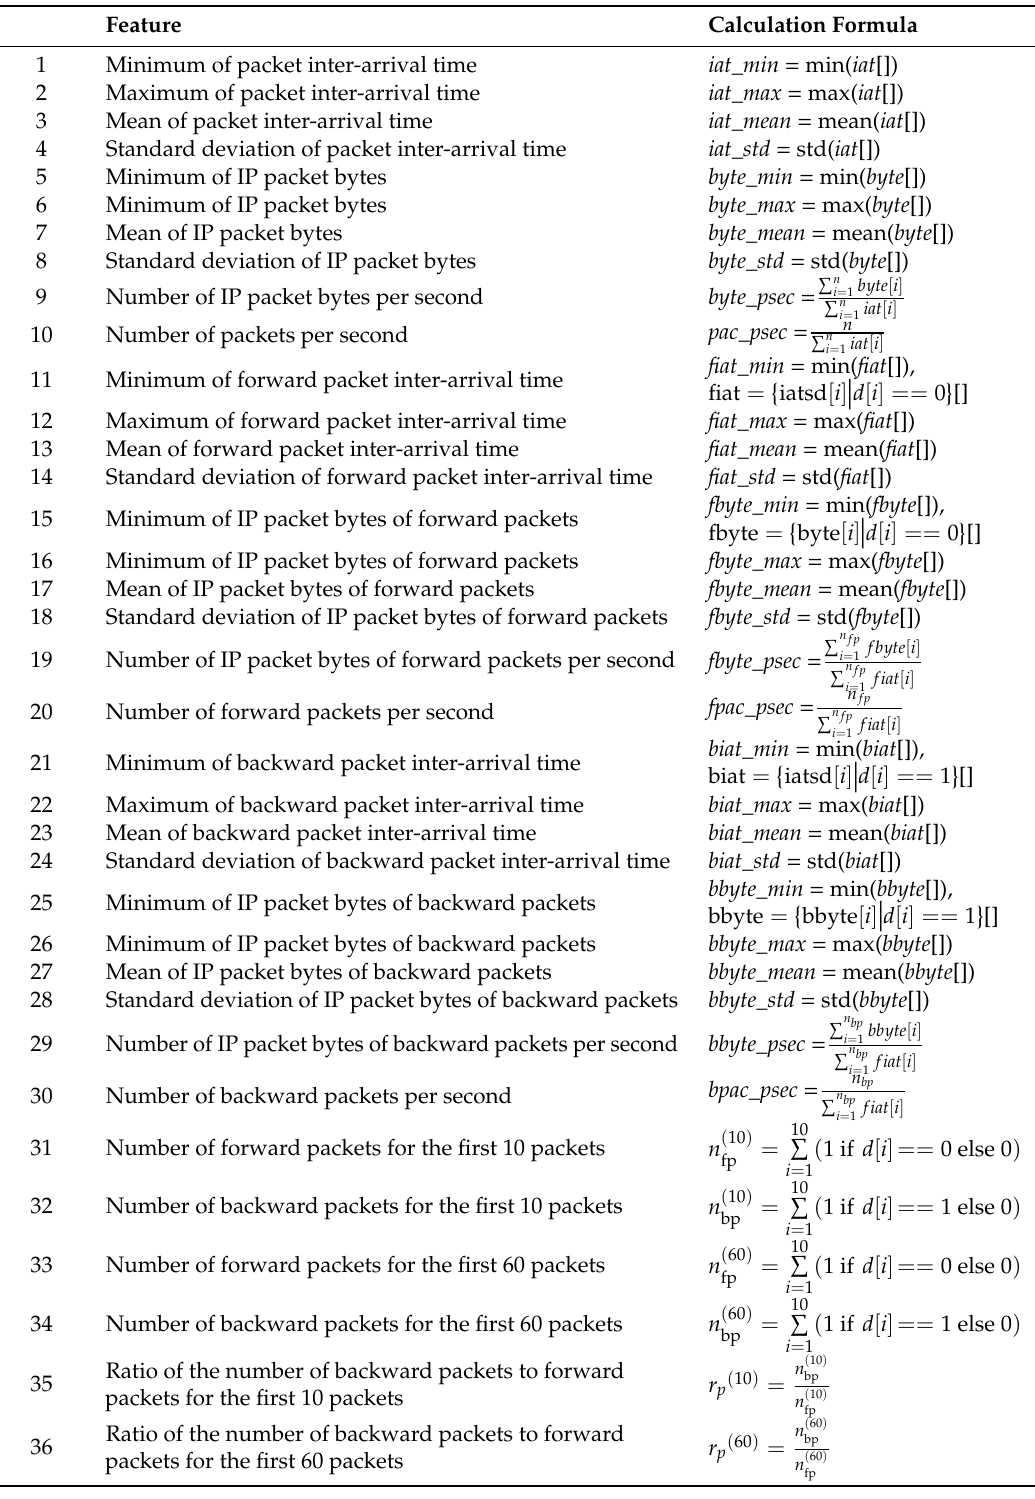
Table 1. Description of candidate flow feature